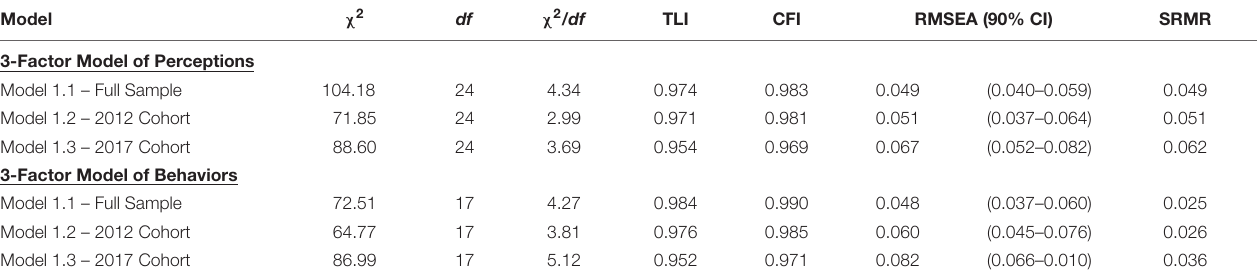
TABLE 2 | Model fit statistics for the two three-factor measurement models of perceptions and behaviors. Model χ 2 df χ 2 /